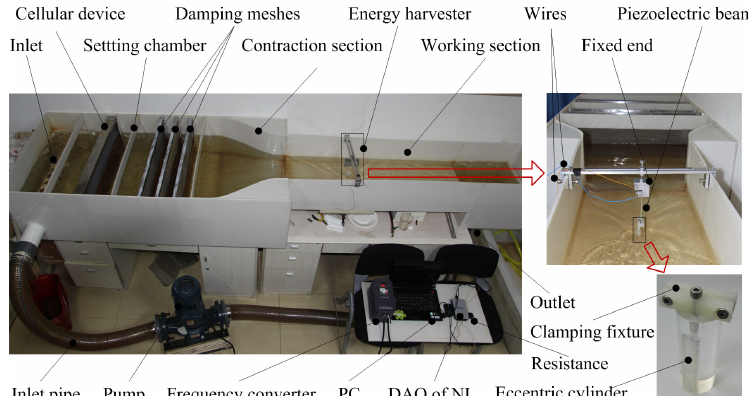
Figure 5. Experimental test platform.